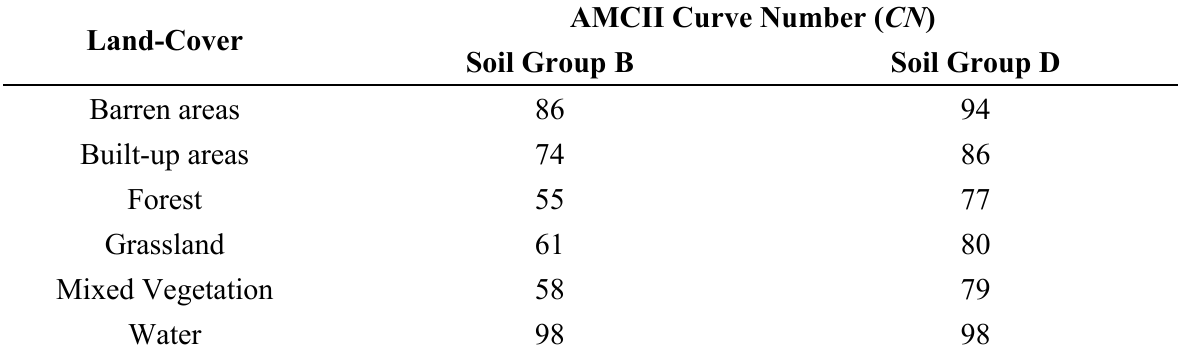
Table 2. AMCII CN values for different land-cover types under hydrologic soil groups B and D which are prevalent in the study area. (Source: SCS National Engineering Handbook